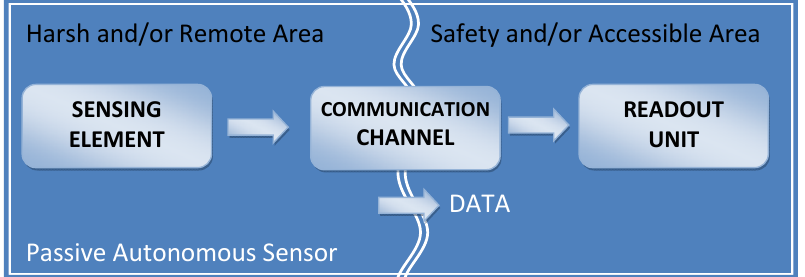
Figure 1. Block diagram of a passive autonomous